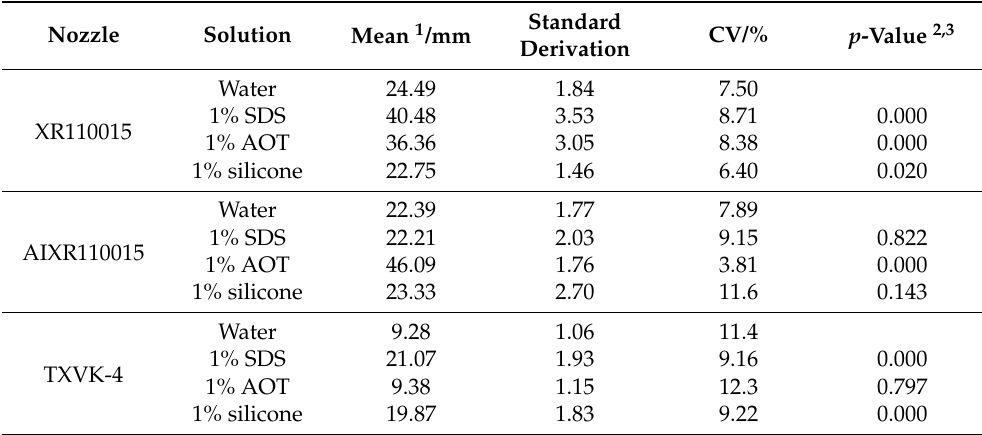
Figure 7. Liquid sheet length of four solutions for three kinds of nozzles. Table 3. Mean, standard derivation, CV values, and significance analysis of the liquid sheet length for three types of nozzles under spray pressure of 0.3